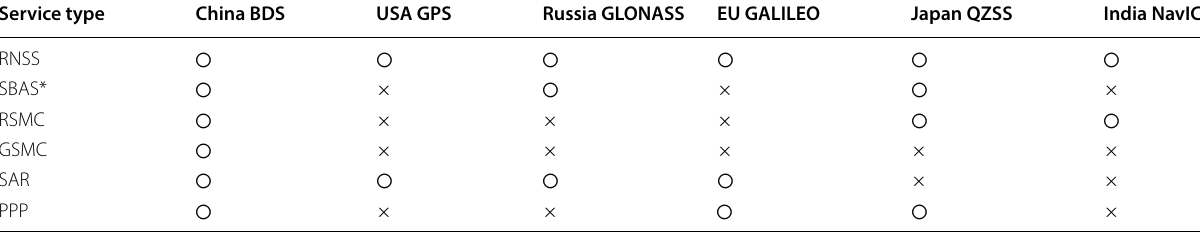
Table 6 The Provision of Featured Services for Major Satellite Navigation Systems